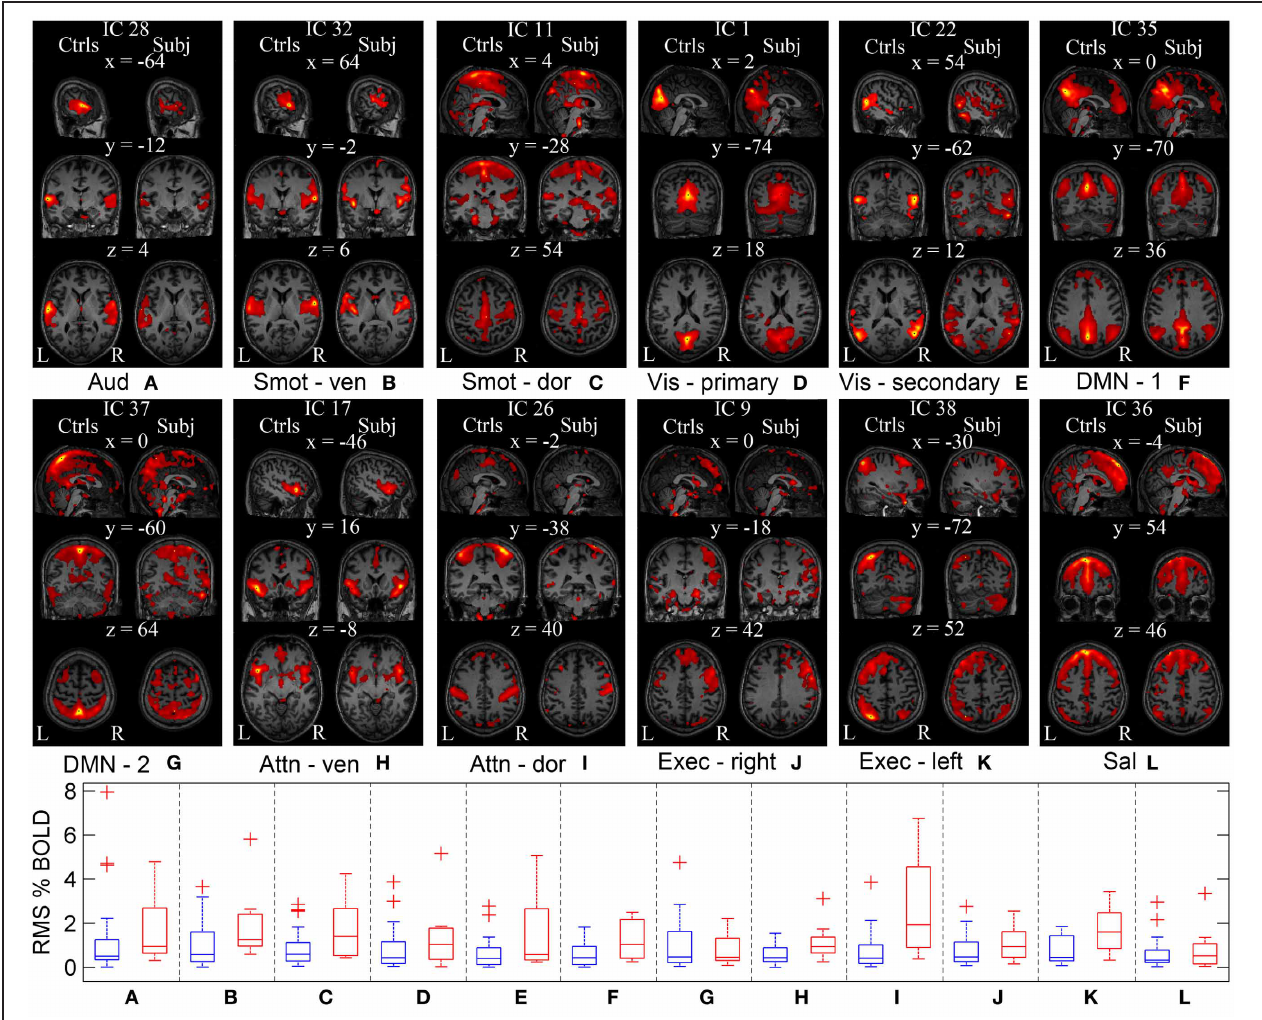
FIGURE 5 | Functional networks of the controls and the patient estimated using GICA. GICA was performed to delineate same functional networks in the controls and the patient. ICs are overlaid on the Montreal Neurological Institute (MNI) template. (A–L) First column corresponds to the sagittal, coronal, and axial view of the controls’ functional networks. Second column corresponds to the patient’s functional networks. Coordinates (in